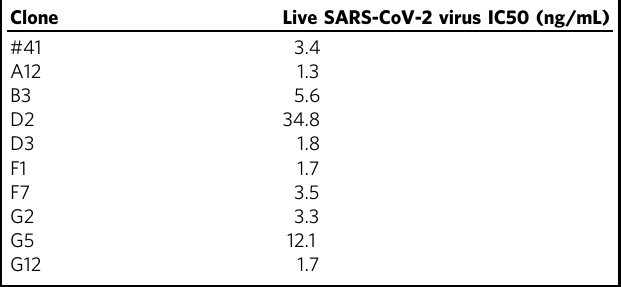
Table 2 Neutralization potencies of the selected antibodies obtained against the SARS-CoV-2